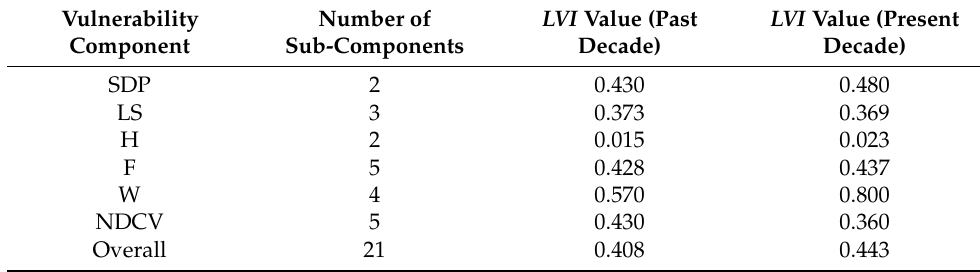
Table 5. Estimated LVI s and their component values for the two decades for Polder